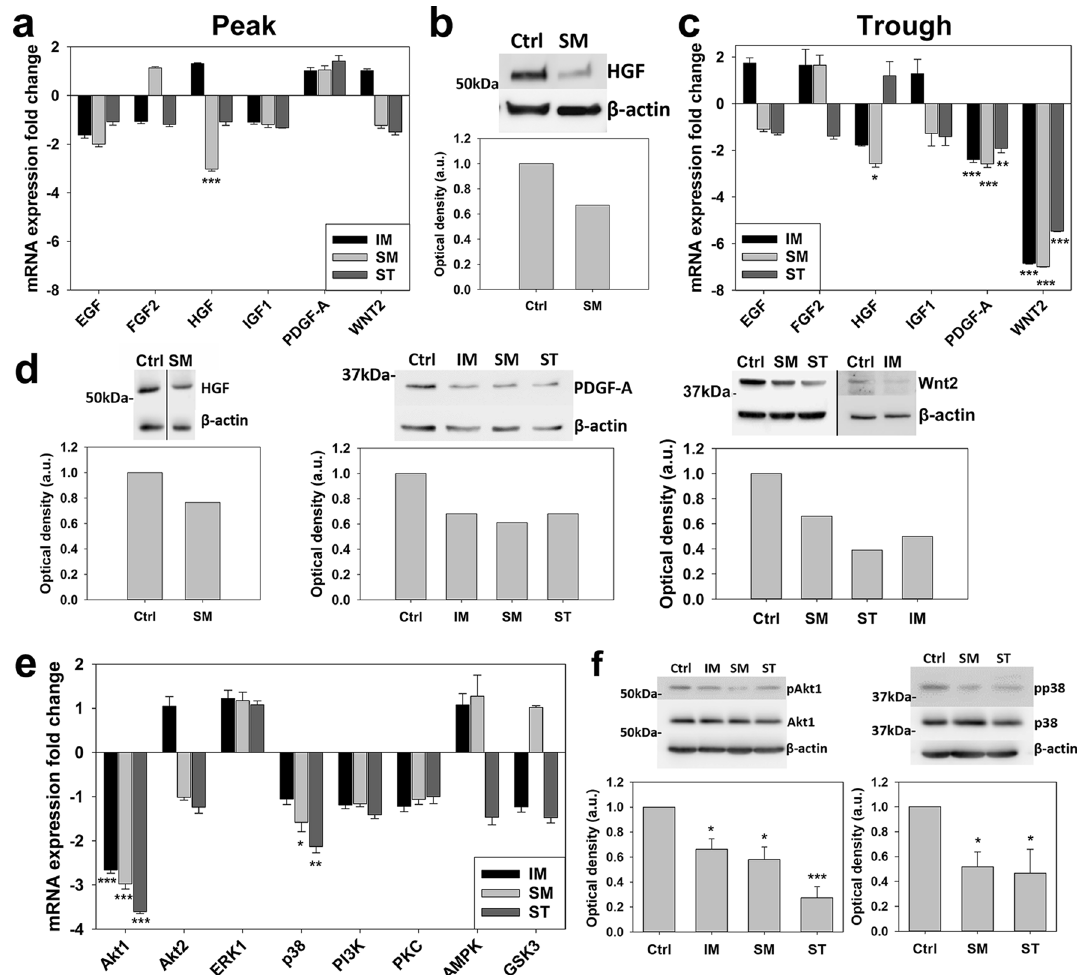
Figure 4. Pro-survival CPC secretome and second messengers inhibited by RTKIs. Real-time qPCR and Western blot analysis of RTKI effects on growth factor expression: ( a ) 10 µM SM for 24 h reduced HGF mRNA (n = 3), with ( b ) protein expression also assessed. HGF expression was reduced by IM or SM, PDGF-A and Wnt2 expression by 5 µM IM, 0.5 µM SM or 5 µM ST at 7 days, shown by ( c ) mRNA (n = 3) and ( d ) protein expression. Real-time qPCR and Western blot analysis of CPC second messenger expression following RTKI exposures: Akt1 expression levels reduced by 5 µM IM, 0.5 µM SM or 5 µM ST at 7 days, with p38 reduced by 0.5 µM SM or 5 µM ST at 7 days, with ( e ) mRNA (n = 3) and ( f ) level of phosphorylated protein/total protein normalized to the loading control (n = 3). All data are mean ± SEM; significance was determined by ANOVA with Holm-Šídák post hoc test to identify differences (* p < 0.05; ** p < 0.01; *** p < 0.001). Blots cropped to relevant data, with optical density normalized to the loading control protein; full blot images presented